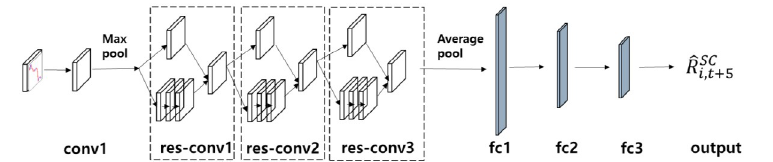
Fig 8. Construction of the SC-CNN model using residual learning and the bottleneck method.